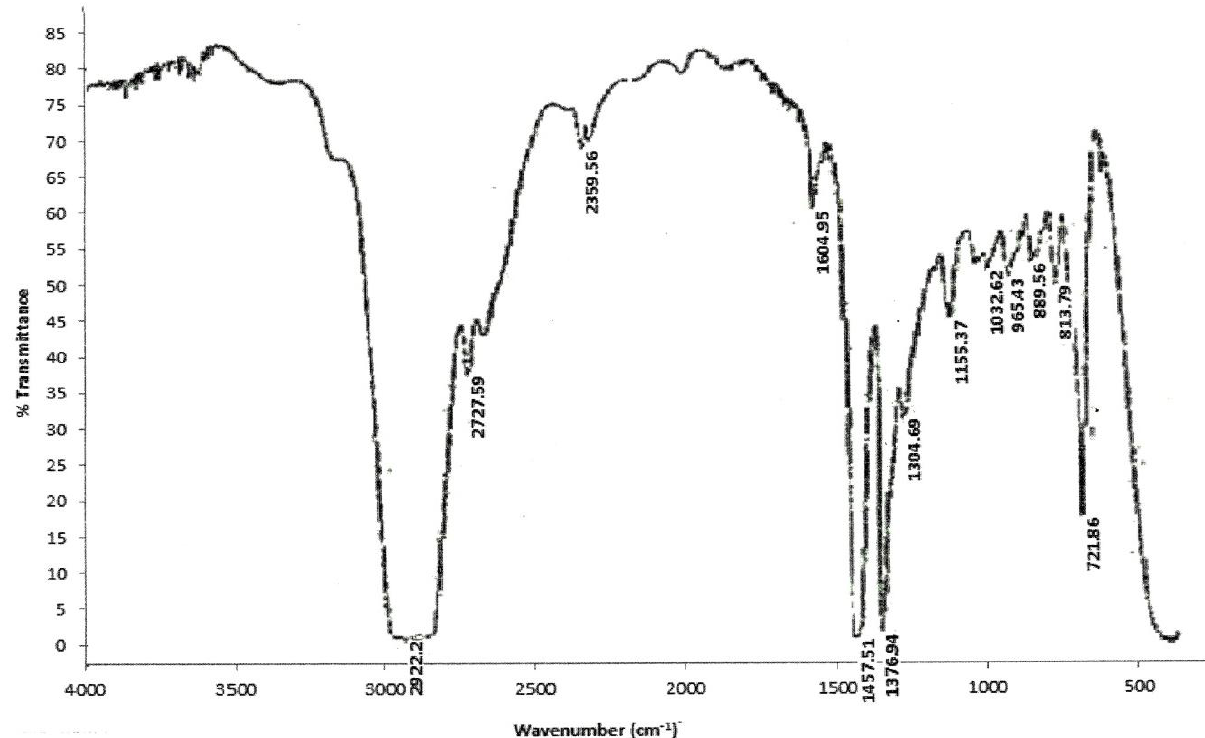
Figure 6. Results of analysis of the recycled oil (base oil only before adding the additives) by vacuum distillation-clay method in local companies in Kurdistan/Iraq.